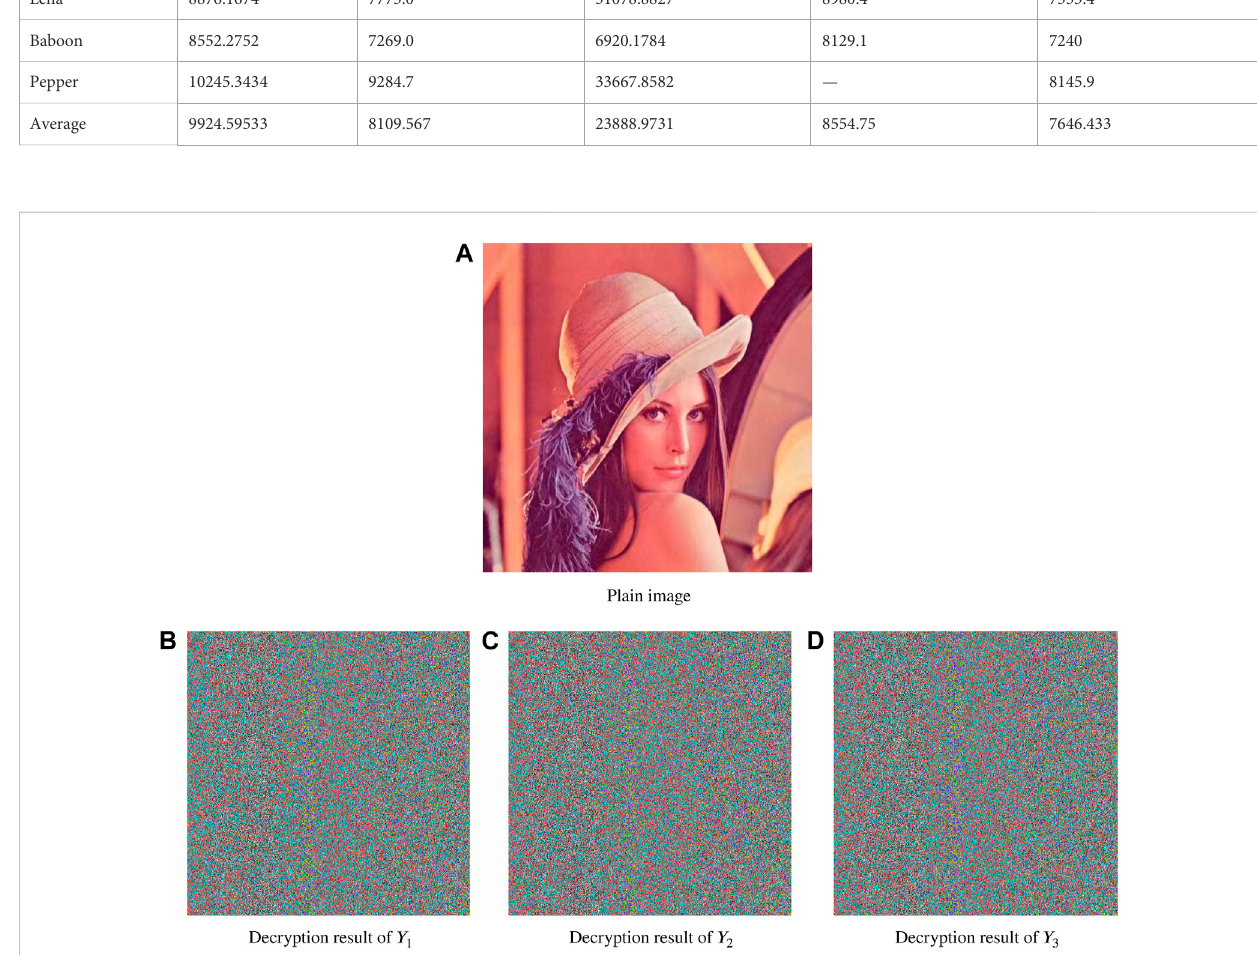
FIGURE 8 Test results of sensitivity analysis. (A) Plaintext image. (B) Decryption result of Y 1 . (C) Decryption result of Y 2 (D) Decryption result of Y 3